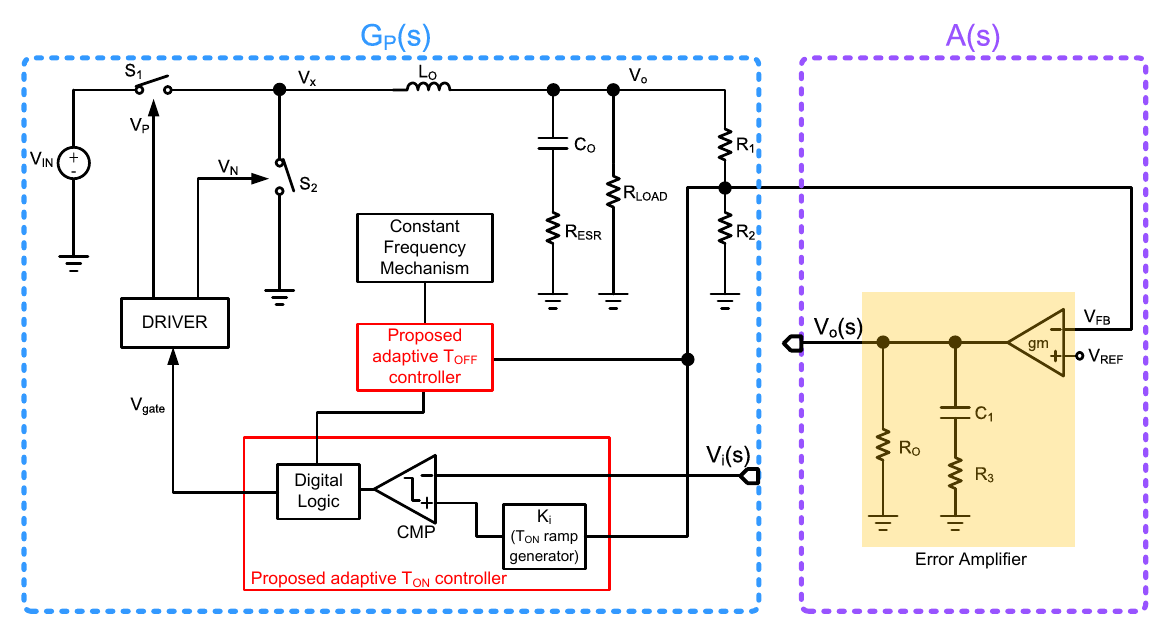
Figure 5. Block diagram of the overall transfer function.